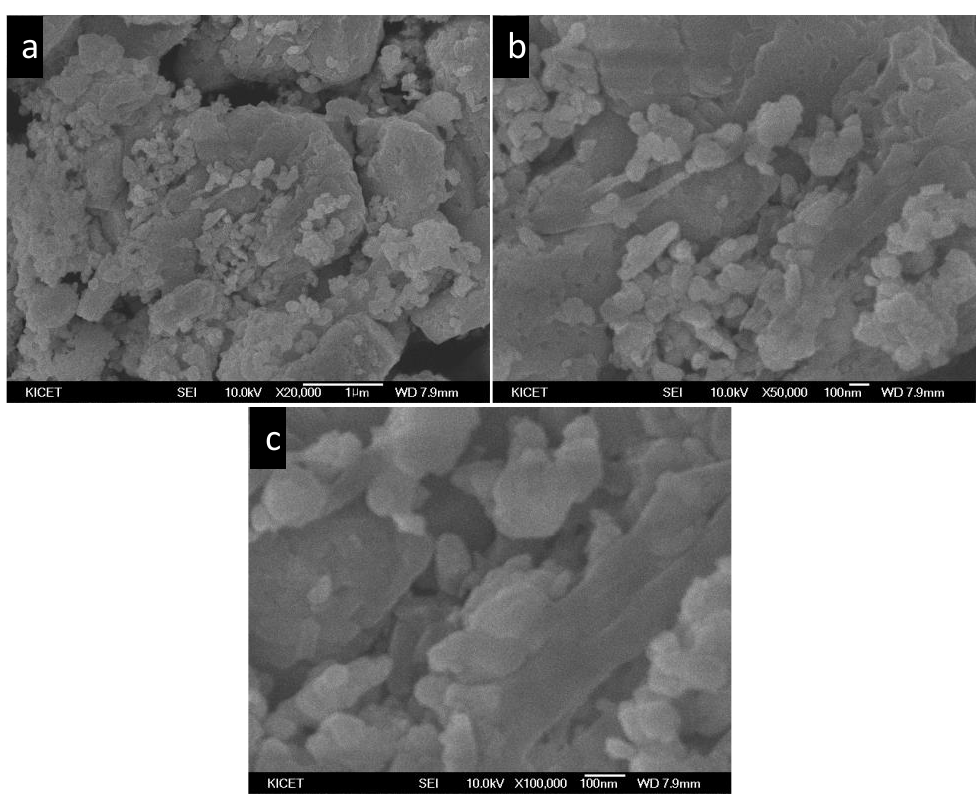
Figure 2. ( a – c ) SEM images of CdTiO 2 nanocomposite.